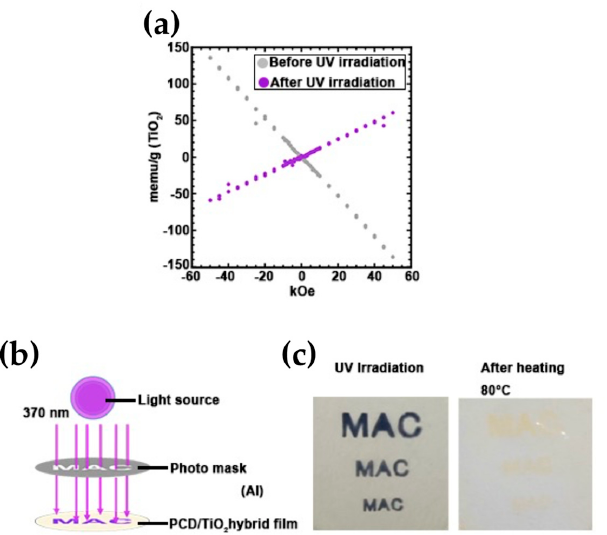
Figure 6. ( a ) Superconducting quantum interference device (SQUID) magnetometry measurements of PC100: before (grey plot) and after (purple plot) UV irradiation. ( b ) Image of the photolithography of PC100 using a UV light source. ( c ) Photograph of PC100 upon photolithography and heat treatment.